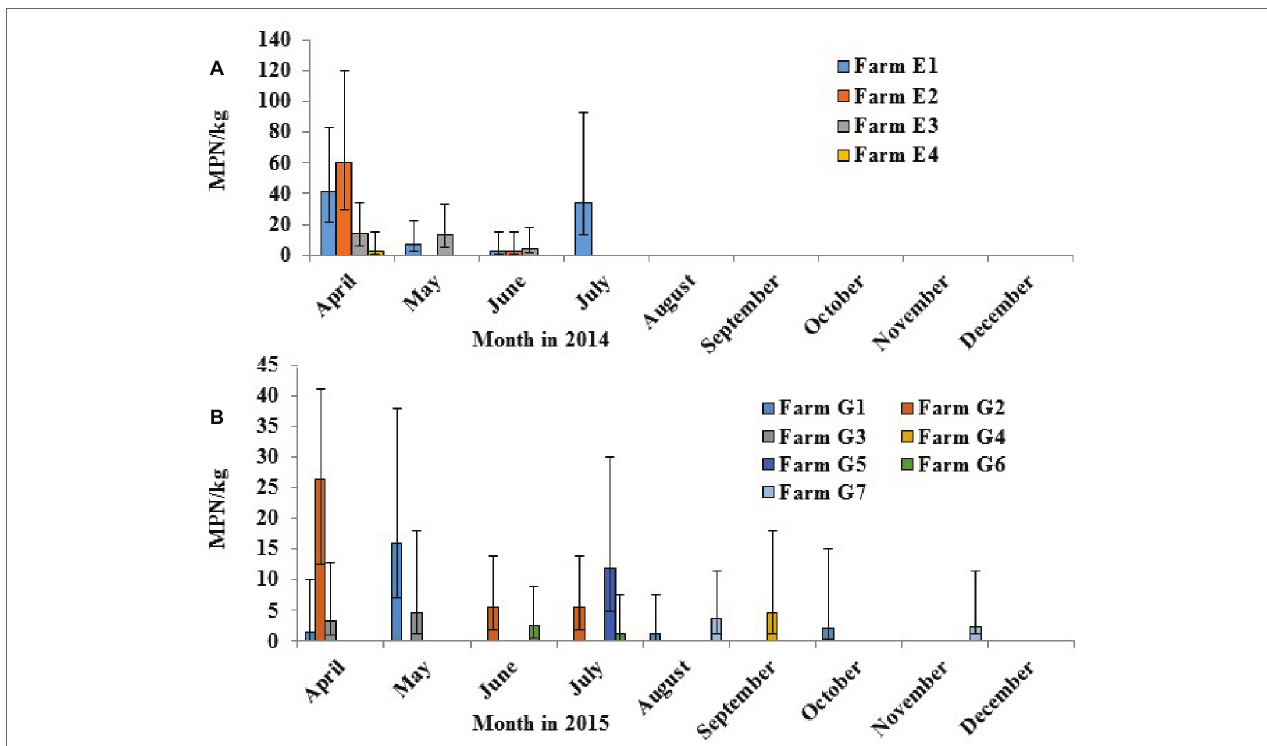
FIGURE 6 | Prevalence of Salmonella in field soils in 2014 [ (A) tested positive in 4 of 10 crop farms with poultry litter fertilization in April] and in 2015 [ (B) positive in the 7 of 14 farms with poultry litter fertilization in April (G1–G3) or in May